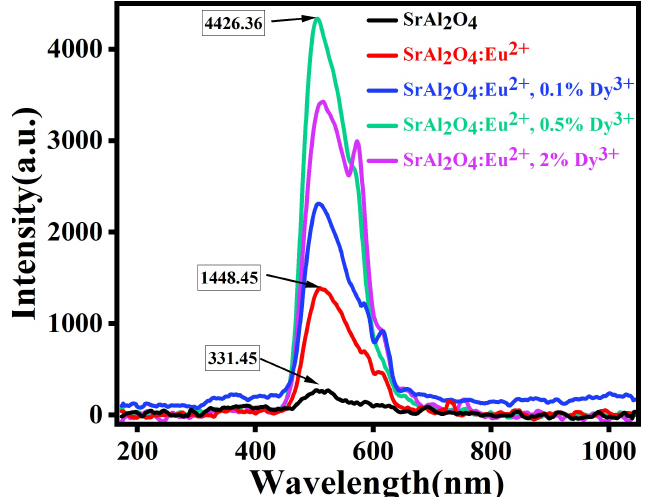
Figure 6. X-ray fluorescence spectra of different samples.